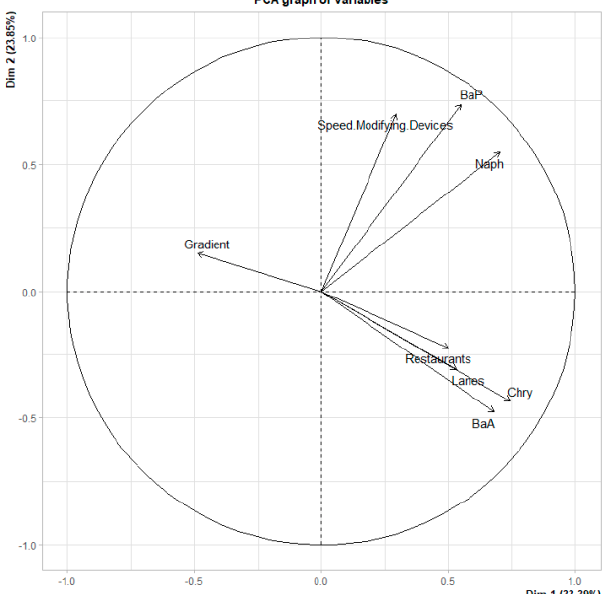
Figure 5. Graph of the variables of the principal component analysis. Naph, naphthalene; BaA, benzo[ a ]anthracene; Chry, chrysene; BaP, benzo[ a ]pyrene.